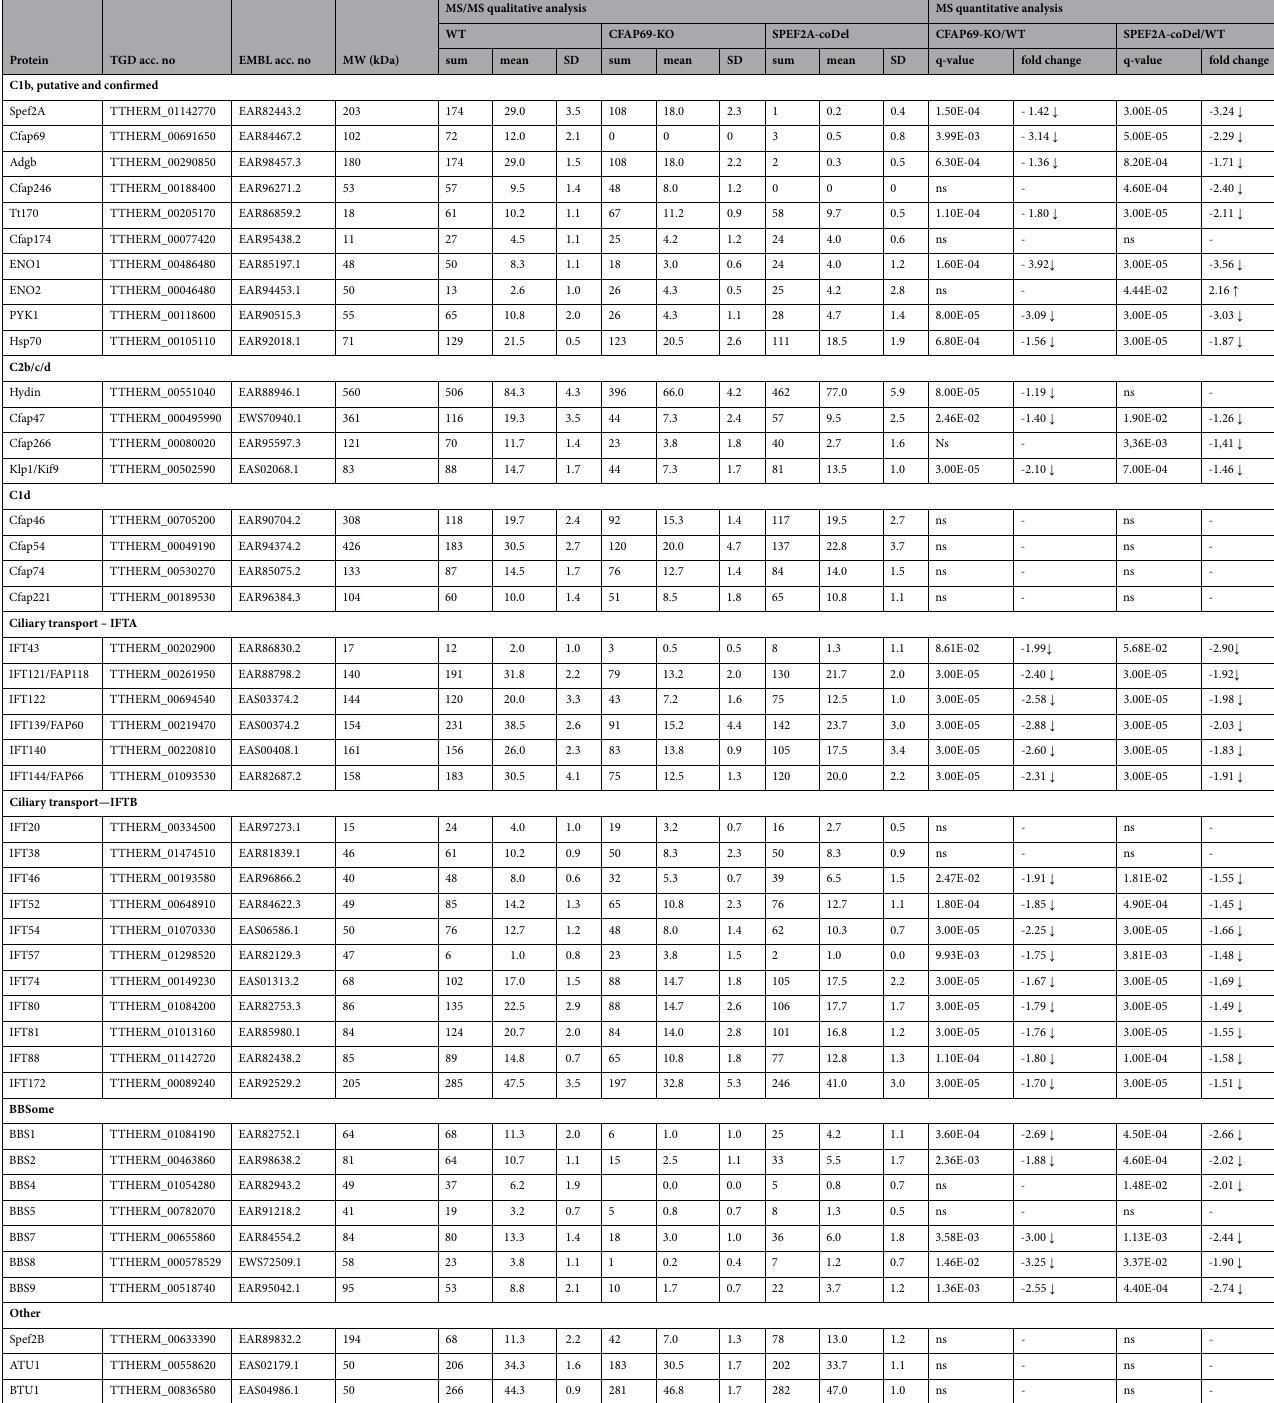
Table 3. Mass spectrometry analysis of the selected proteins in cilia assembled by wild-type, CFAP69-KO and SPEF2A-coDel mutants. Qualitative MS/MS analysis: sum represents all identified peptides in six analyzed samples, mean – mean number of peptides per sample, SD – standard deviation. Quantitative MS analysis: q-value—FDR corrected p-value for Diffprot. Abbreviations: ENO – enolase, PYK – pyruvate kinase, IFT – intraflagellar transport, BBS – Barded-Biedl syndrome, ATU1 – α-tubulin, BTU1 –